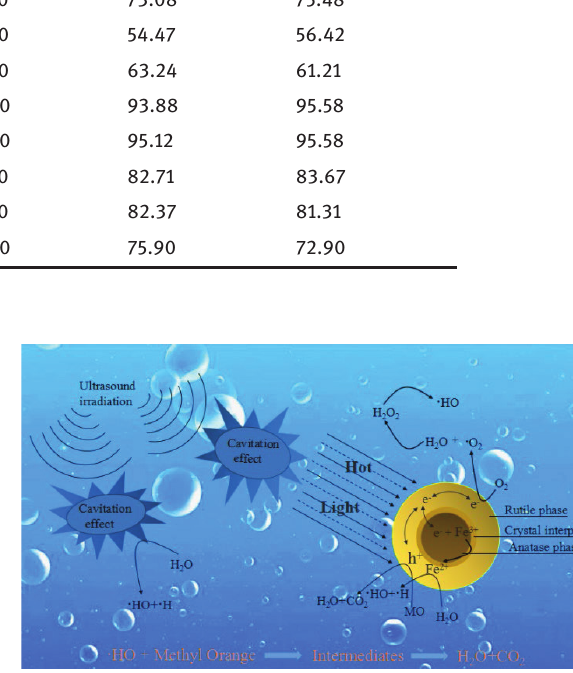
Figure 11: Effect of scavenging compounds on methyl orange sonocatalytic degradation rate (Ethanol = 0.6 M, Sodium chloride= 0.06 mM)